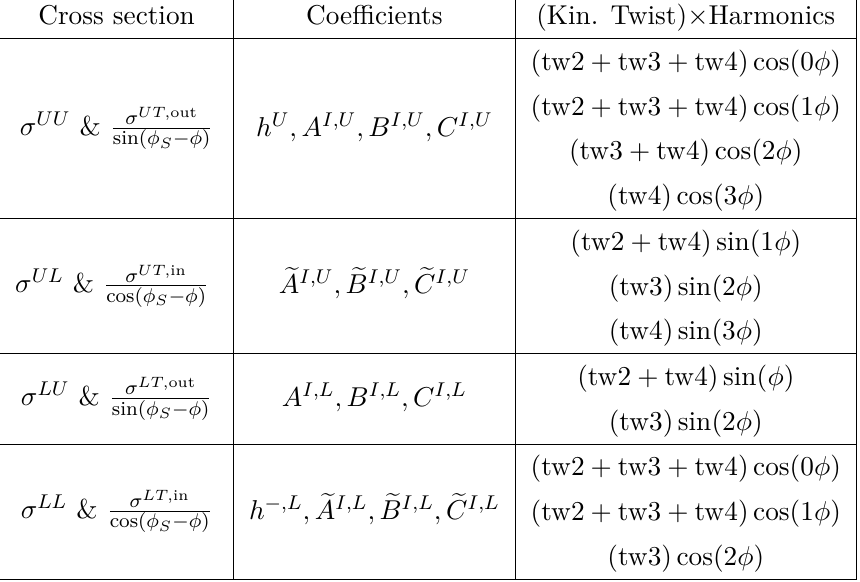
Table 1. A list of the harmonic observables for each polarized DVCS cross section along with their hierarchy of kinematical twist contributions. Note that the out-of-plane polarized cross section behaves the same as the unpolarized one in terms of kinematics except for an overall factor of sin( φ ) . The same applies to the in-plane polarized cross-section and the longitudinally polarized S − φ one, except for an overall factor of cos( φ ) for the in plane polarized cross S − φ